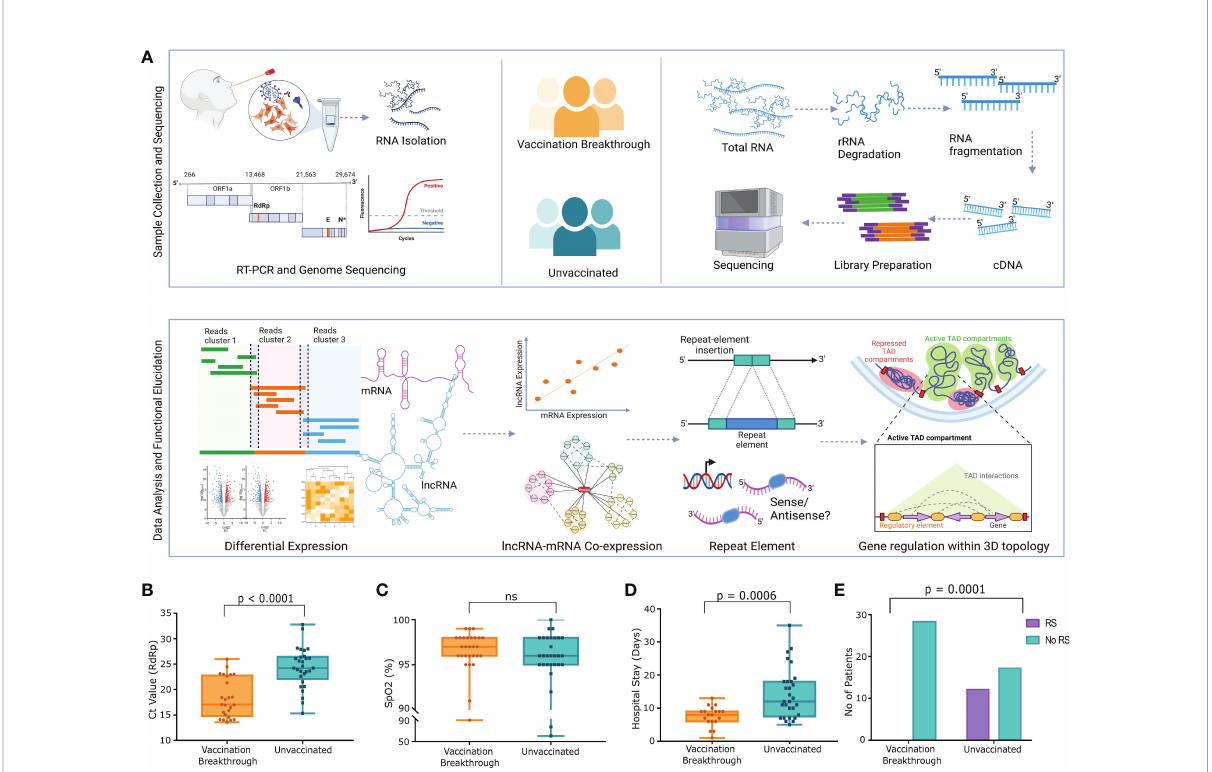
FIGURE 1 Study design, experimental work fl ow, and clinical data of the SARS-CoV-2 Infected Individuals across VBT and unvaccinated. (A) Study design and experimental work fl ow including the sample collection, SARS-CoV-2 genome sequencing, human host transcriptome, data analysis and the functional interpretation. (B) Ct value of the SARS-CoV-2 RdRp gene, (C) SpO 2 (%) levels of the VBT and unvaccinated individuals, (D) Duration of hospital stay, and (E) Number of patients requiring respiratory support between the VBT and the unvaccinated individuals. Upper bar shows statistical signi fi